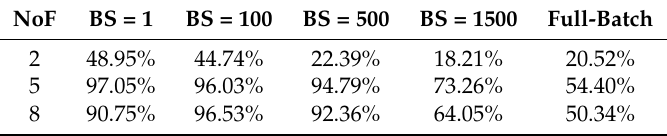
Table 5. Effect of PCA-based feature selection on the designed MLP’s performance ( HLN = 30).